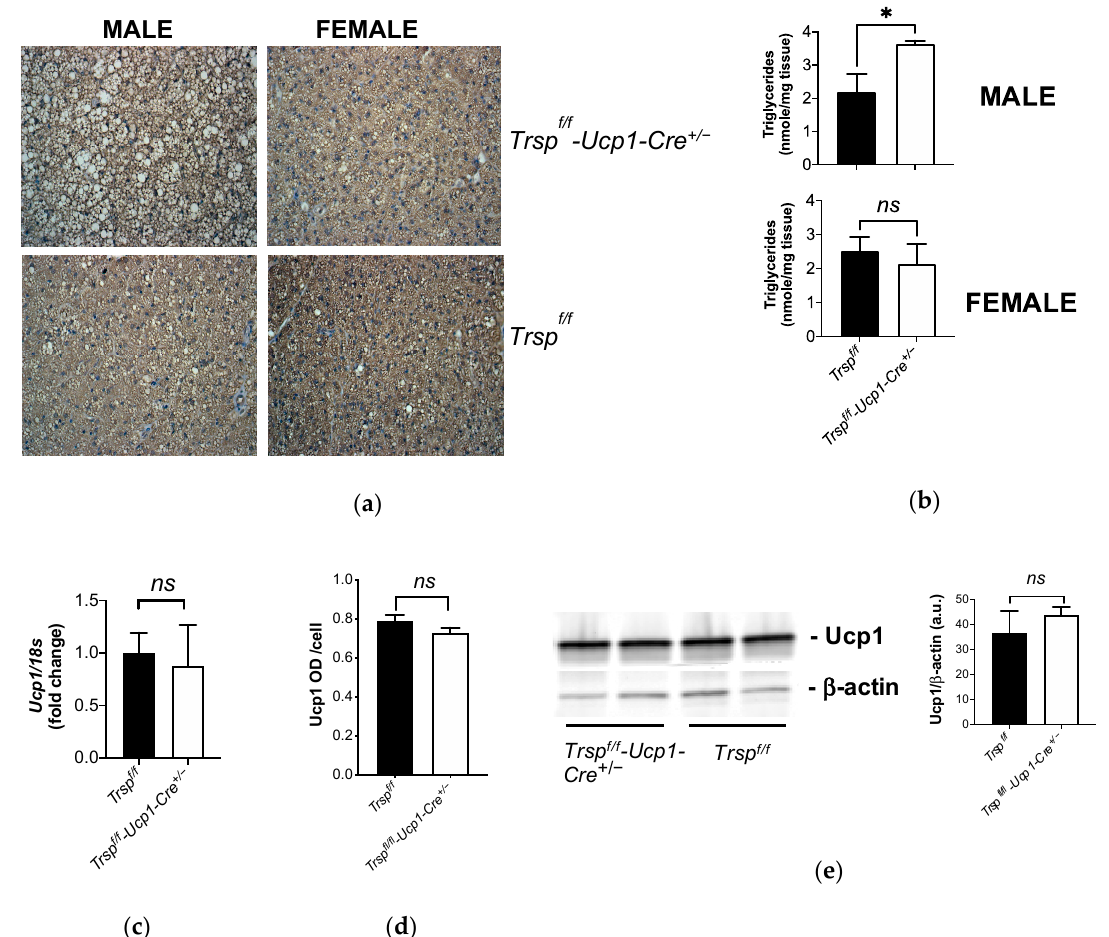
Figure 3. BAT morphology and Ucp1 expression in Trsp f/f -Ucp1-Cre +/ − mice. ( a ) Representative images of BAT histology after hematoxylin staining, n = 11. ( b ) BAT triglyceride content of Trsp f/f -Ucp1-Cre +/ − mice ( n = 7 per sex). ( c ) Ucp1 mRNA expression in male Trsp f/f -Ucp1-Cre +/ − mice. ( d ) Ucp1 levels as assessed by optical densitometry after Ucp1 immunohistochemistry of male samples in ( a ). ( e ) Western blot ( n = 11) image of Ucp1 levels and graph with band densitometry calculation. Values are mean ± SD, and p -values were calculated using unpaired Student’s t -test. ns , non-significant; * p <0.05.